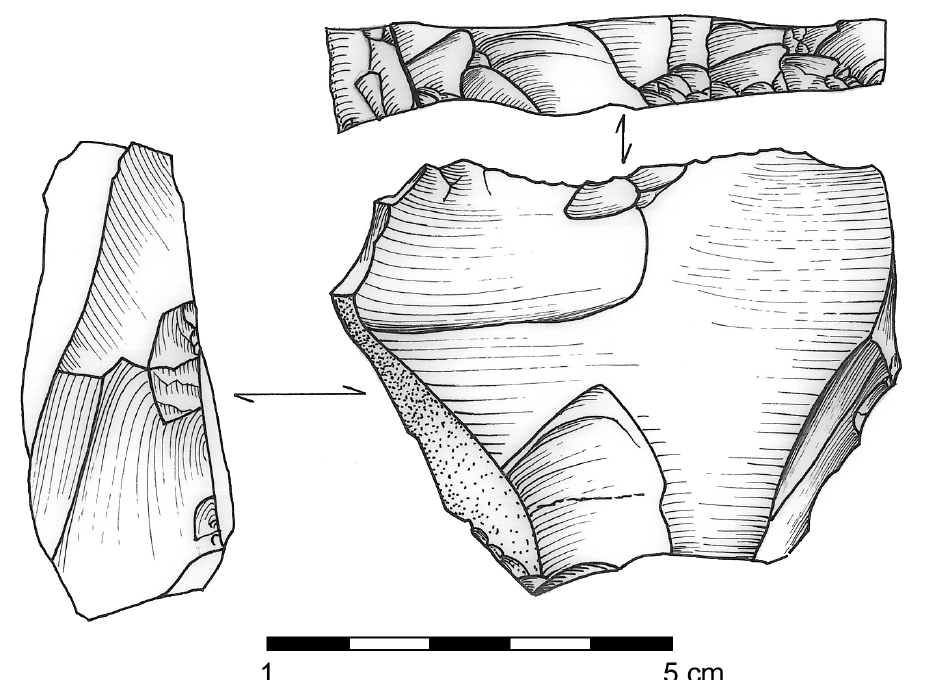
Figure 6. Tablette de ravivage de plan de frappe du site de Saint-Pierre-d’Autils « Le Plaquis » (Eure). Dessin de D. Prost. Figure 6. Rejuvenation core tablet from Saint-Pierre-d'Autils site. Drawing by D. Prost.